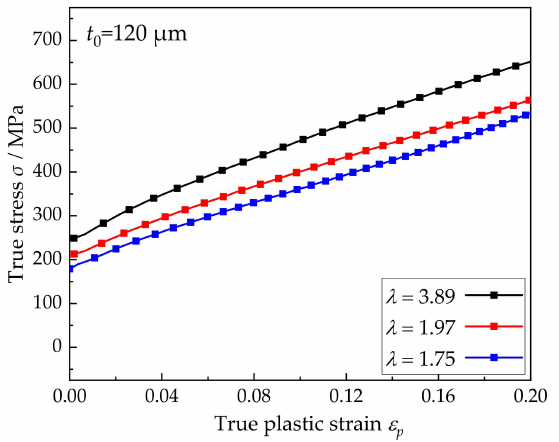
Figure 3. True stress–true plastic strain curves of foils with different grain